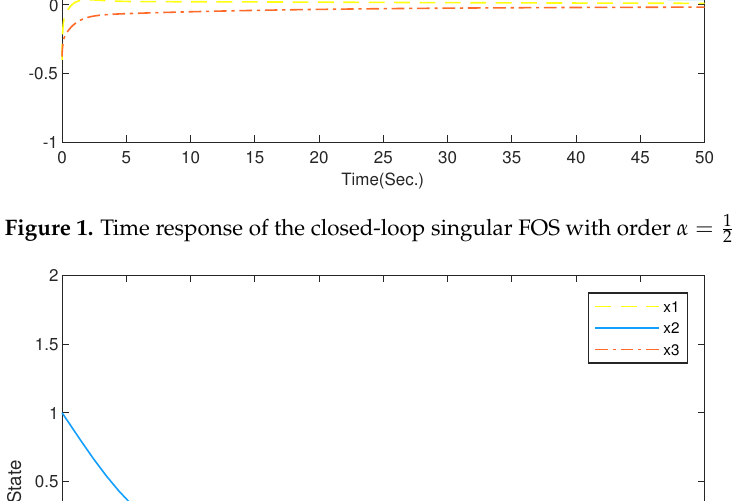
Figure 1. Time response of the closed-loop singular FOS with order α = 1